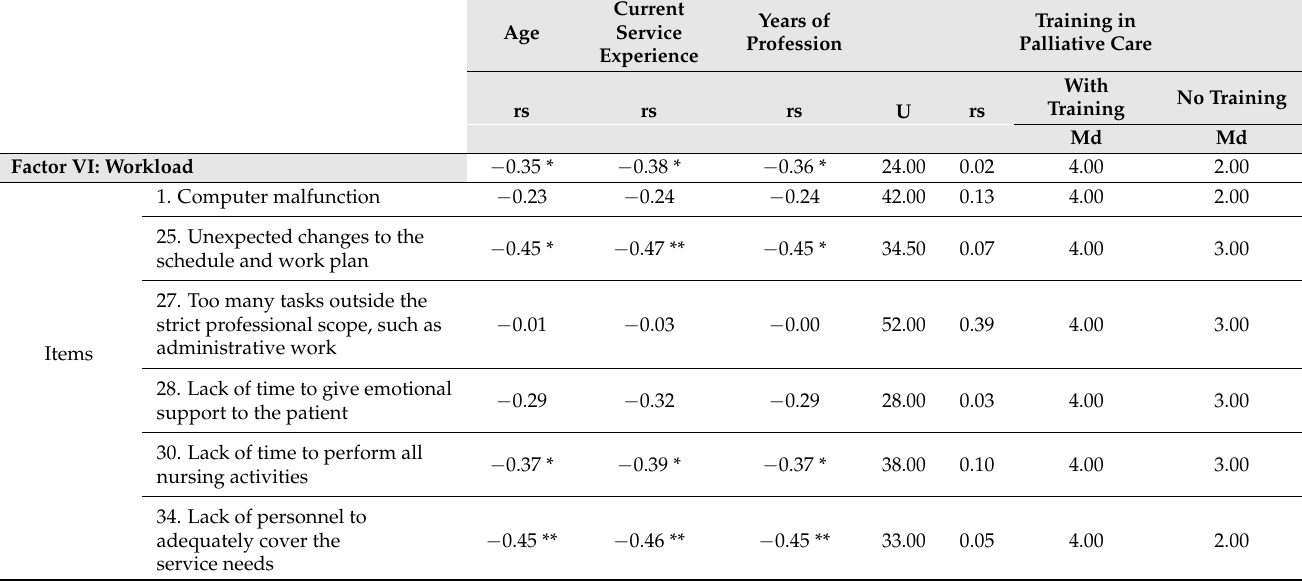
Table 4. Statistical analysis between organizational domain and demographic and professional